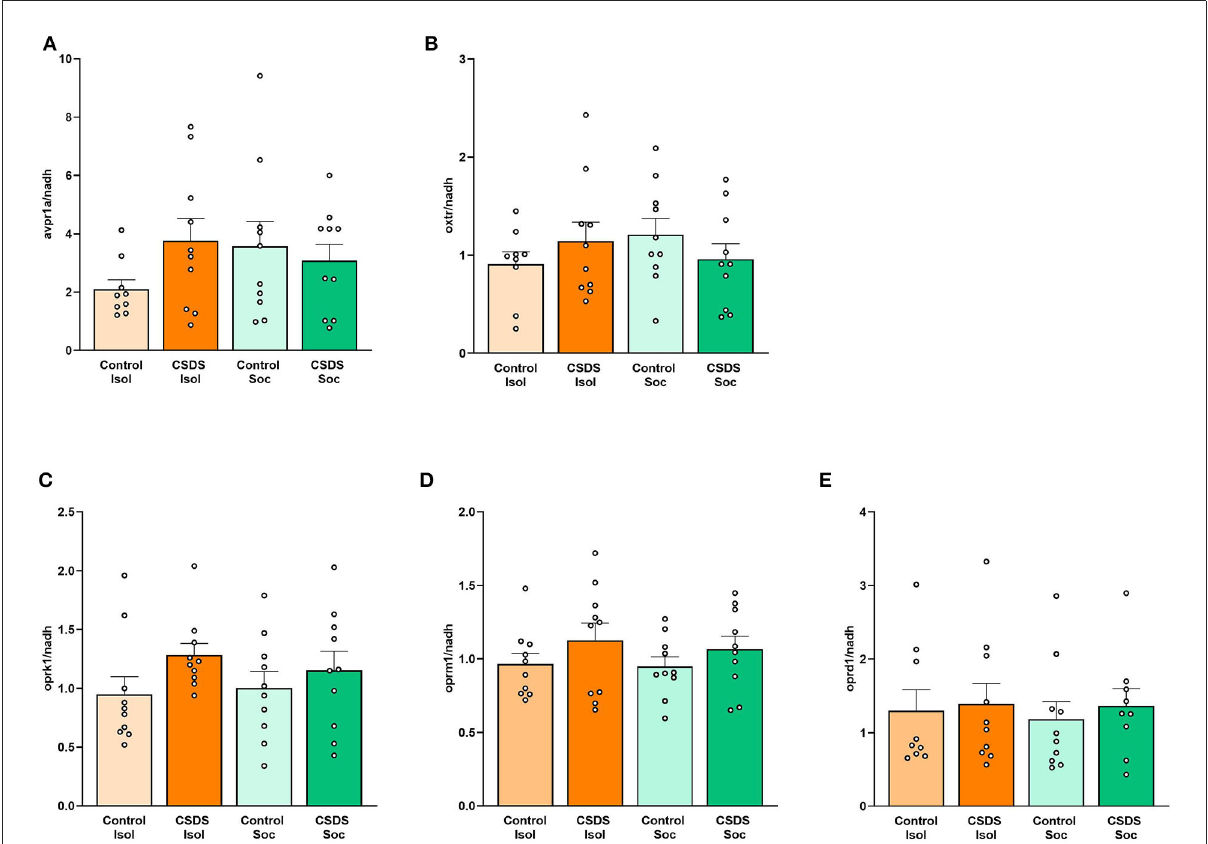
FIGURE5 Effects of social isolation and CSDS on gene expression in the lateral septum. (A) avpr1a , (B) oxtr , (C) oprk1 , (D) oprm1 , and (E) oprd1 mRNA levels in the LS are not significantly associated with vulnerability or resilience to isolation of social stress. Color scheme follows Figure 1 where orange = isolated; green = group-housed; dark colors = chronic social defeat; light colors = control (no chronic social defeat). Data are presented as mean ± SEM and dots represent individual